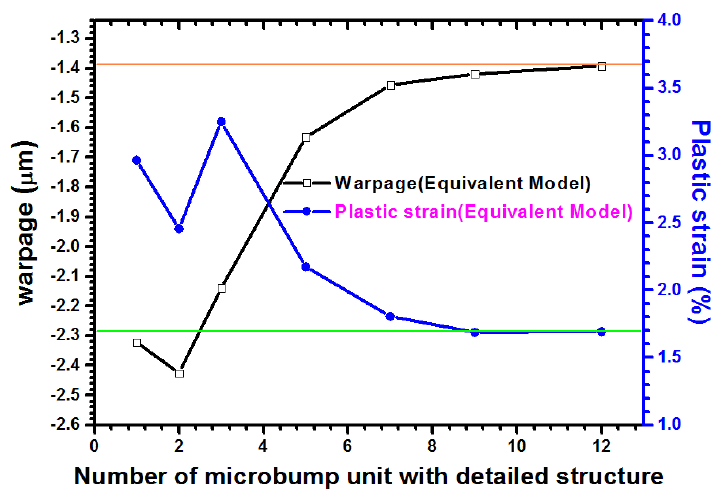
Figure 9. Convergent curves for the maximum warpage of assembled structure and the